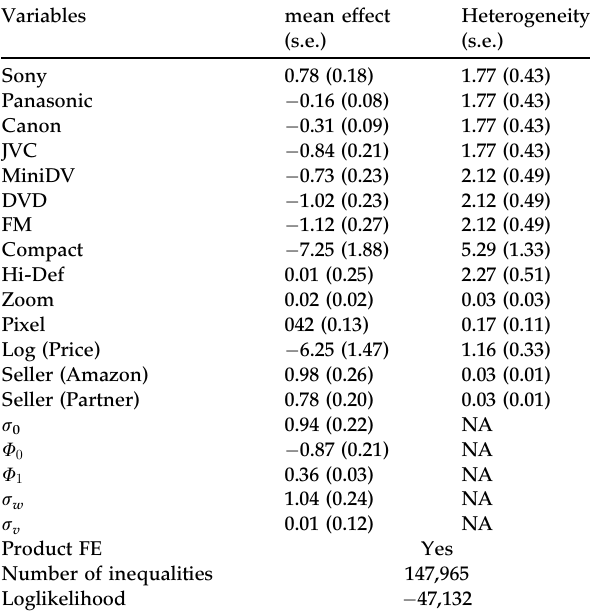
Table 2. Estimated model parameters. Variables mean effect